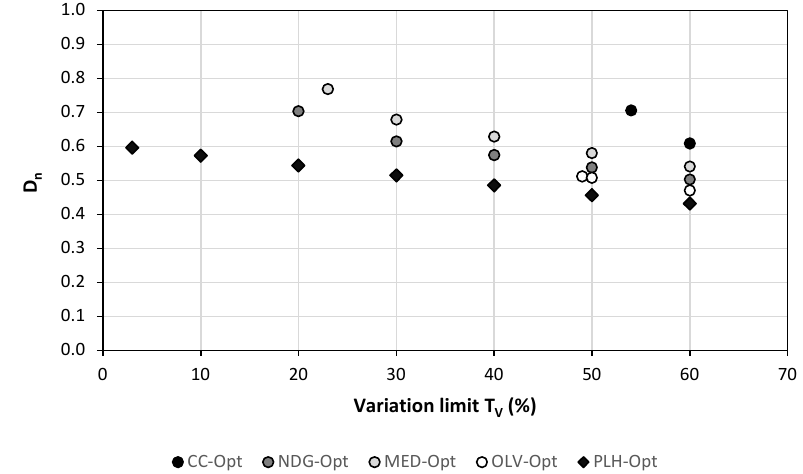
Figure 5. Distance (Dn) for optimal diets with different variation limits.